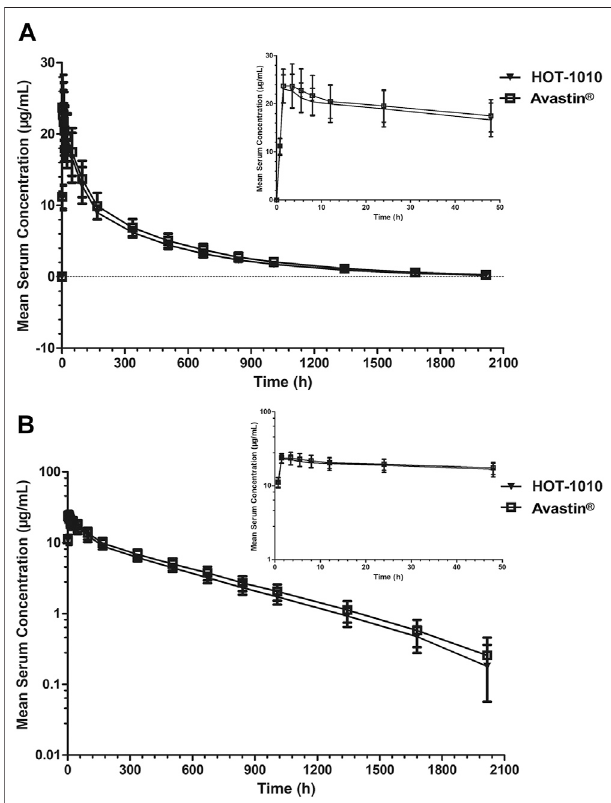
FIGURE 2 | Mean serum concentrations ± SD vs. time pro fi les following intravenousinfusionof1 mg/kgHOT-1010( n (cid:2) 41)orbevacizumab(Avastin ® ) ( n (cid:2) 41) in Chinese healthy male subjects on linear (A) and semilogarithmic scales (B) .